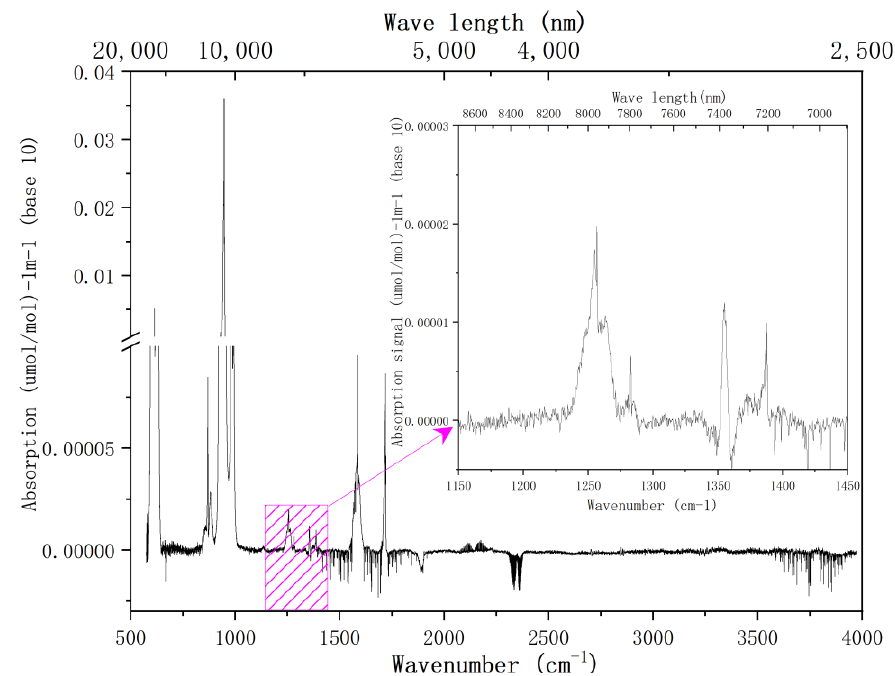
Figure 1. Sulfur hexafluoride absorption spectra simulated using the NIST database.